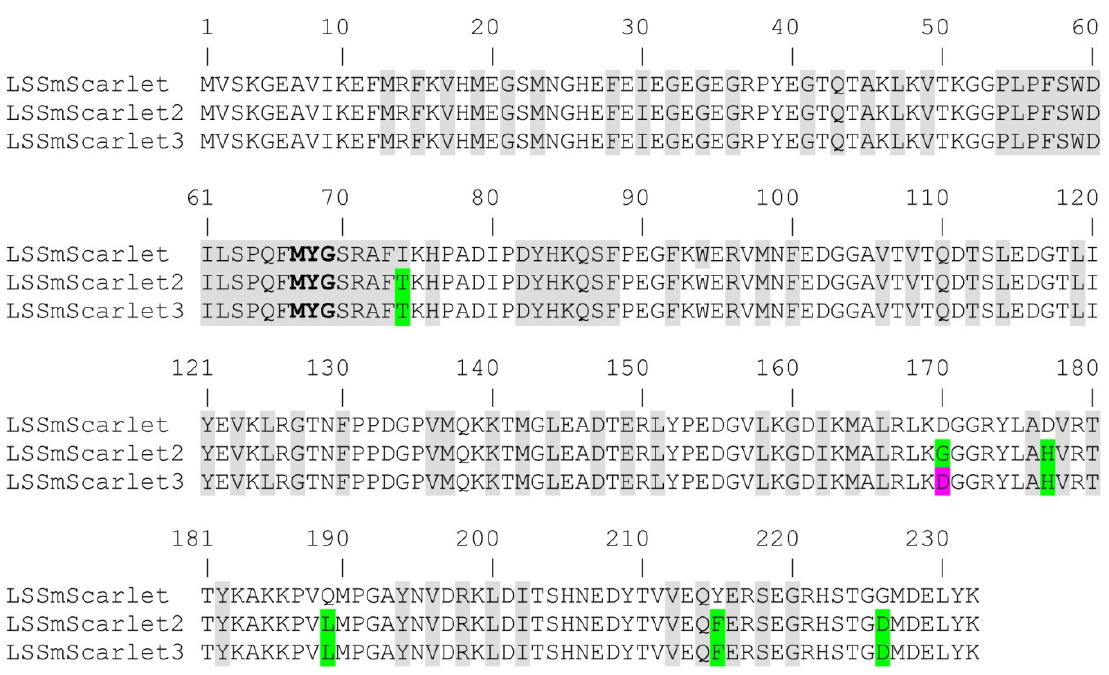
Figure 1. Alignment of the amino acid sequences for the developed LSSRFPs (LSSmScarlet2 and LSSmScarlet3) and the parental protein (LSSmScarlet). Mutations in the developed LSSRFPs are highlighted in green. The mutation in LSSmScarlet3 compared to LSSmScarlet2 is in magenta. Chromophore-forming residues MYG are selected in bold. Residues buried in the β -barrel are in gray.